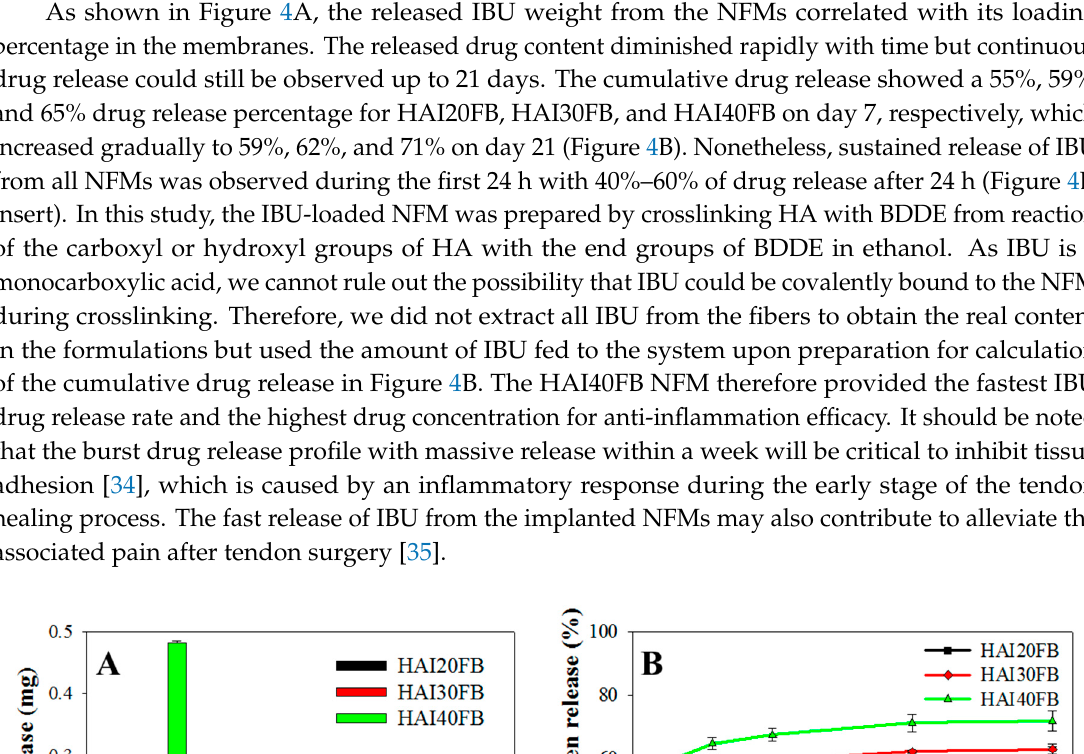
Figure 5. Cytotoxicity of NFMs by culture 3T3 fibroblasts with 24 h extracts (in cell culture medium) of HAI20FB, HAI30FB, and HAI40FB NFMs for 1 and 4 days. The relative cell viability was normalized with cells cultured in fresh cell culture medium (control), which was taken as 100%. * p < 0.05 compared with control; # p < 0.05 compared with HAI20FB; & p < 0.05 compared with HAI30FB.